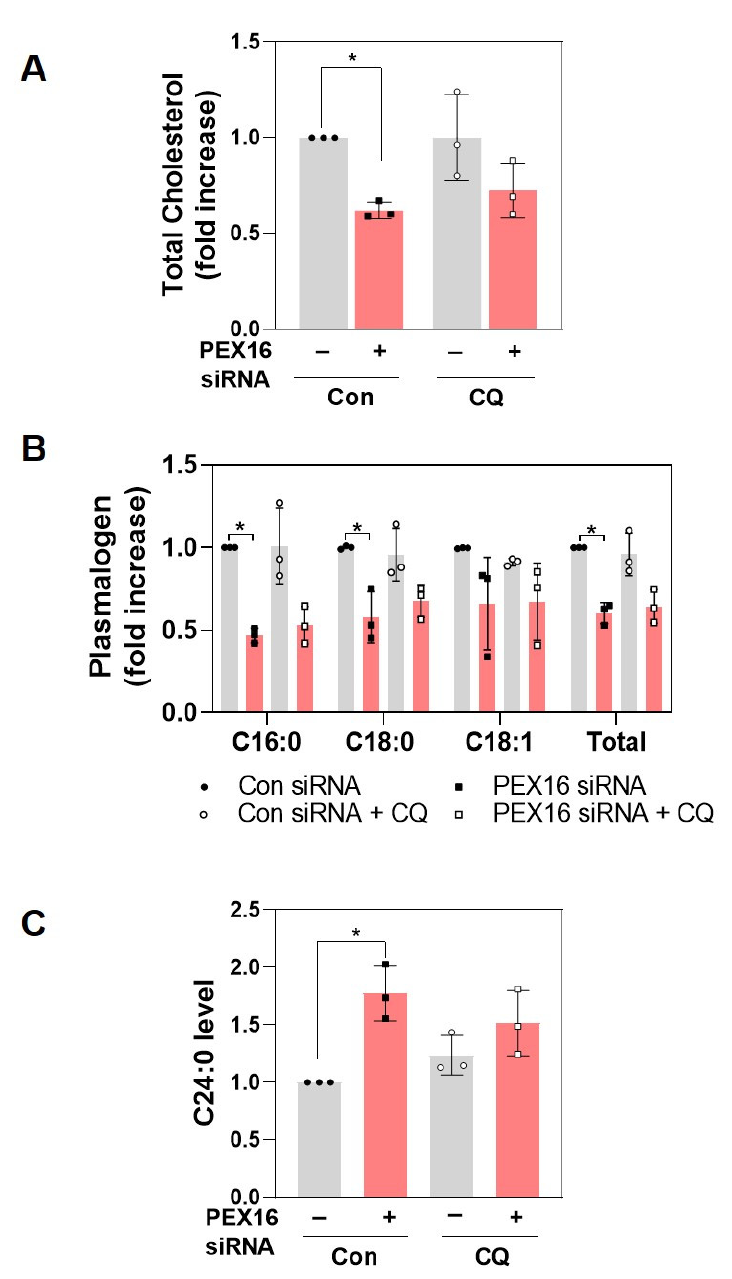
Figure 4. Peroxisome function is not recovered by chloroquine in cells with PEX16 knockdown. RPE-1 cells were treated with siRNA of either control or PEX16 for 12 h, followed by incubation with 5 µ M chloroquine for 60 h. Under this condition, ( A ) the levels of cholesterol and ( B ) plasmalogens were measured. ( C ) VLCFA (C24:0) level was measured. All data are presented as means ± S.D. ( n = 3, independent experiments), * p < 0.05.